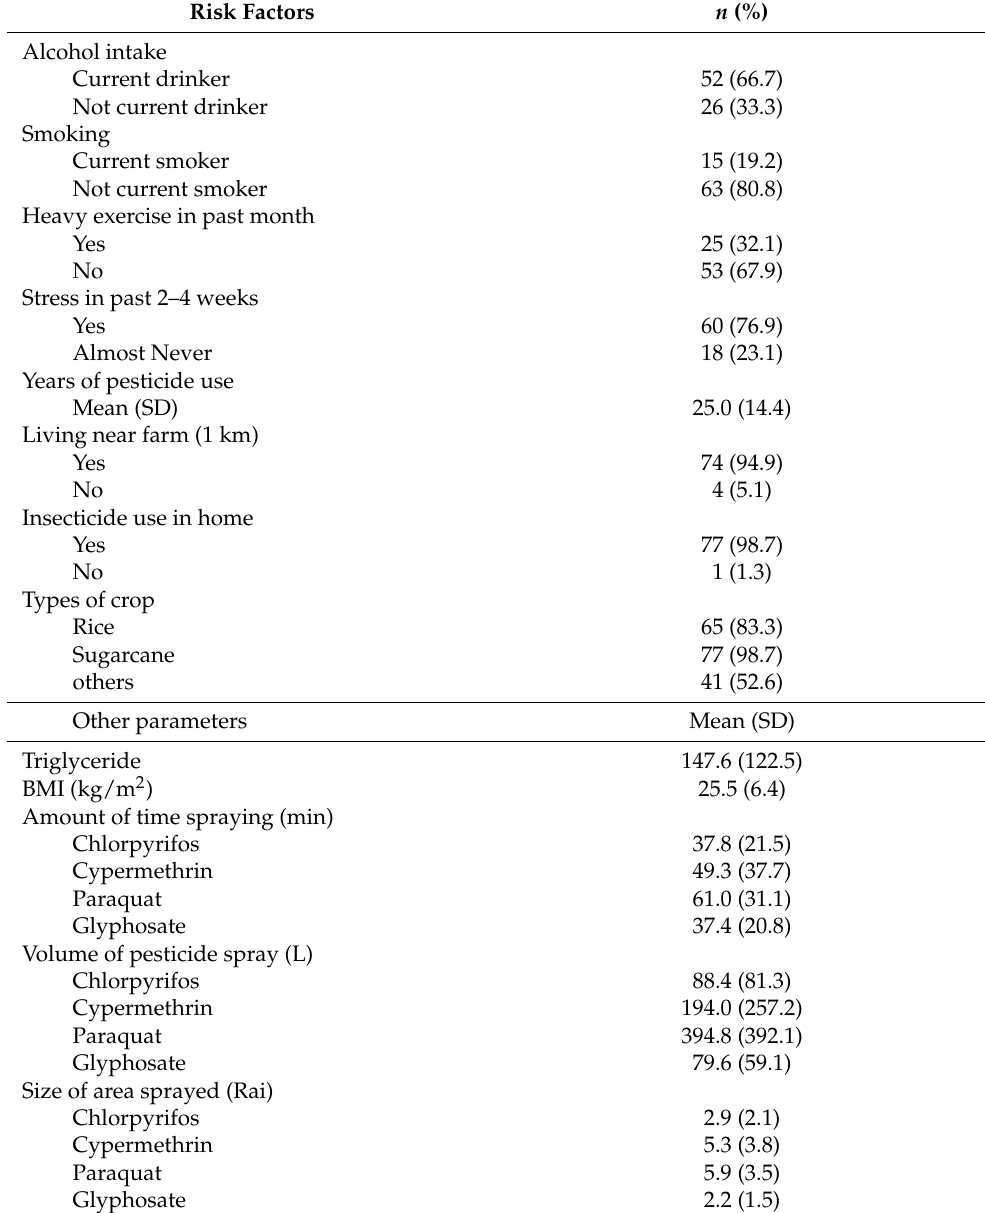
Table 2. Risk factors and spraying factors of conventional farmers ( n = 78) spraying chlorpyrifos, cypermethrin, paraquat and